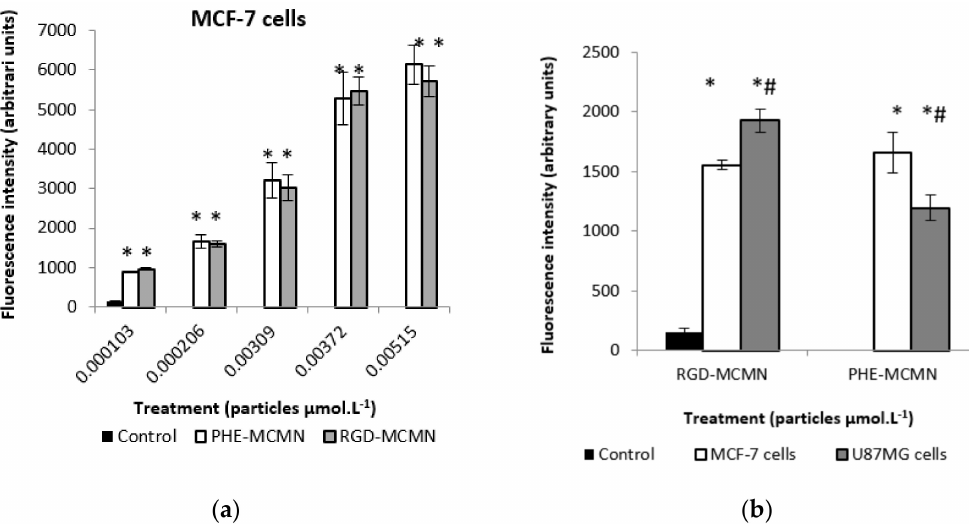
Figure 3. ( a ) Flow cytometry uptake profiles of Phe-MCMN f or RGD-MCMN f by MCF-7 cells treated for 24 h with 1.03 × 10 − 4 , 2.06 × 10 − 4 , 3.09 × 10 − 3 , 3.72 × 10 − 3 and 5.15 × 10 − 3 µ mol of nanocapsules per liter of well; and ( b ) uptake of RGD-MCMN f and Phe-MCMN f by MCF-7 and U87MG cells treated for 24 h with 1.03 × 10 − 4 µ mol of particles per liter of well; control groups did not receive any treatment. Notes: Data are expressed as mean ± standard error. * Indicates significant differences from control; # indicates significant differences compared to the respective concentrations in ( a , b ); * # indicates significant differences between cell lines. Differences were considered significant at p <